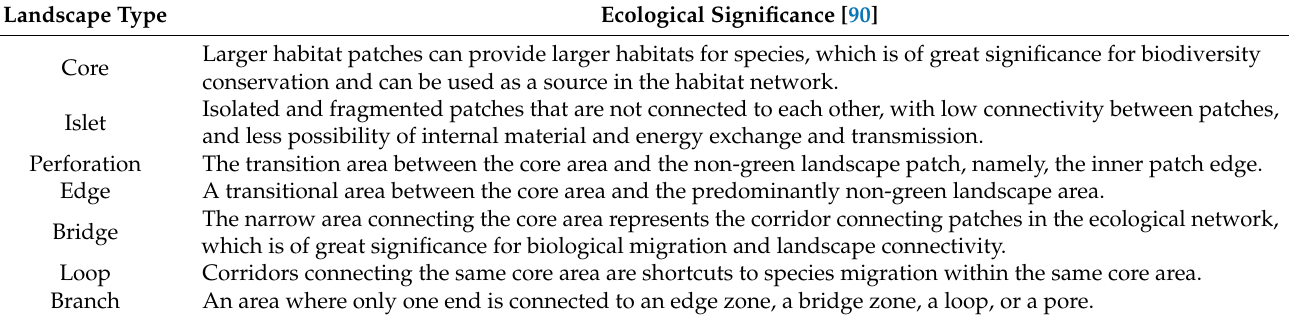
Table 1. MSPA landscape types and their